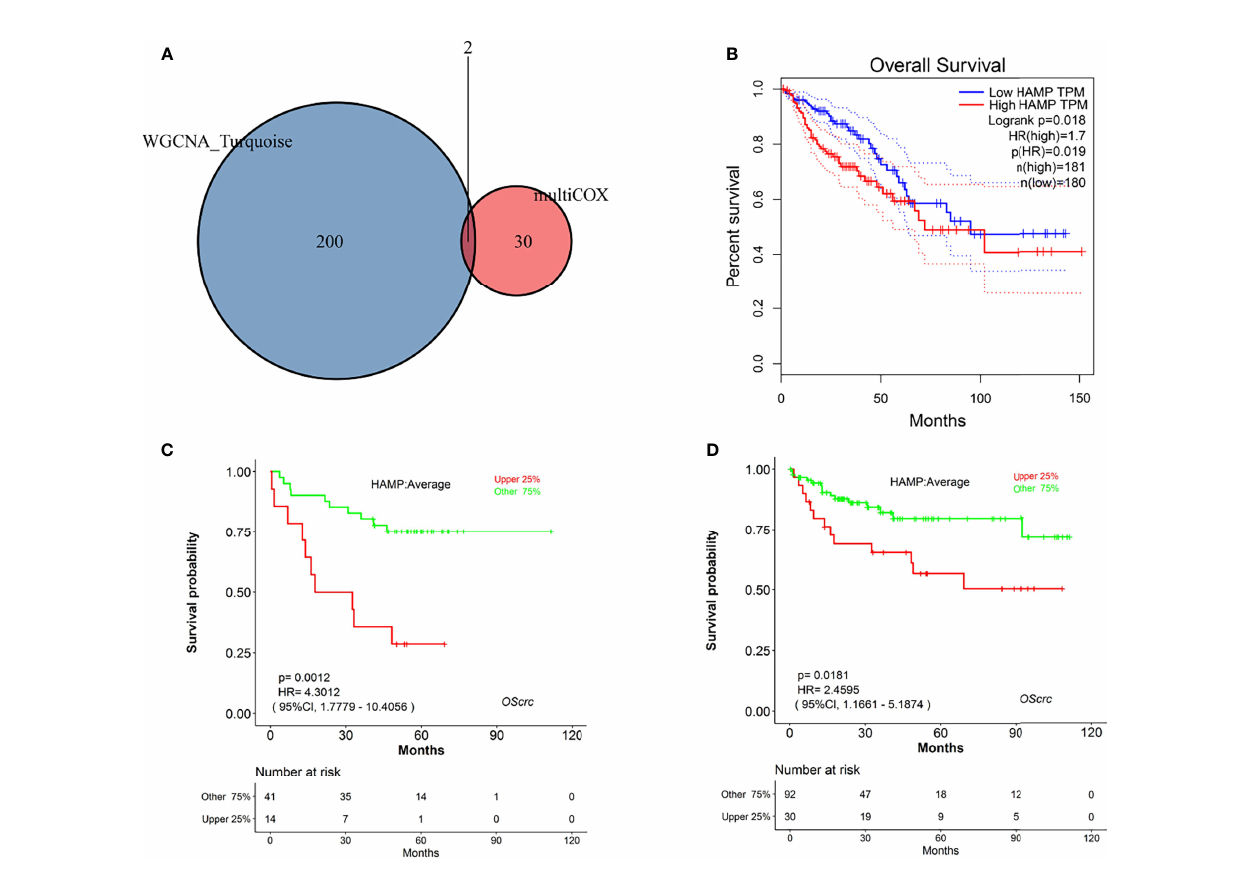
FIGURE 5 | Identi fi cation of hub genes. (A) Venn diagram of genes commonly shared between the turquoise module and those screened by multivariate Cox analysis. (B) Kaplan – Meier plot of HAMP analysis by GEPIA online tools. (C) Kaplan – Meier plot of HAMP in GSE17537 analyzed by LOGpc online tools. (D) Kaplan – Meier plot of HAMP in GSE38832 analyzed by LOGpc online